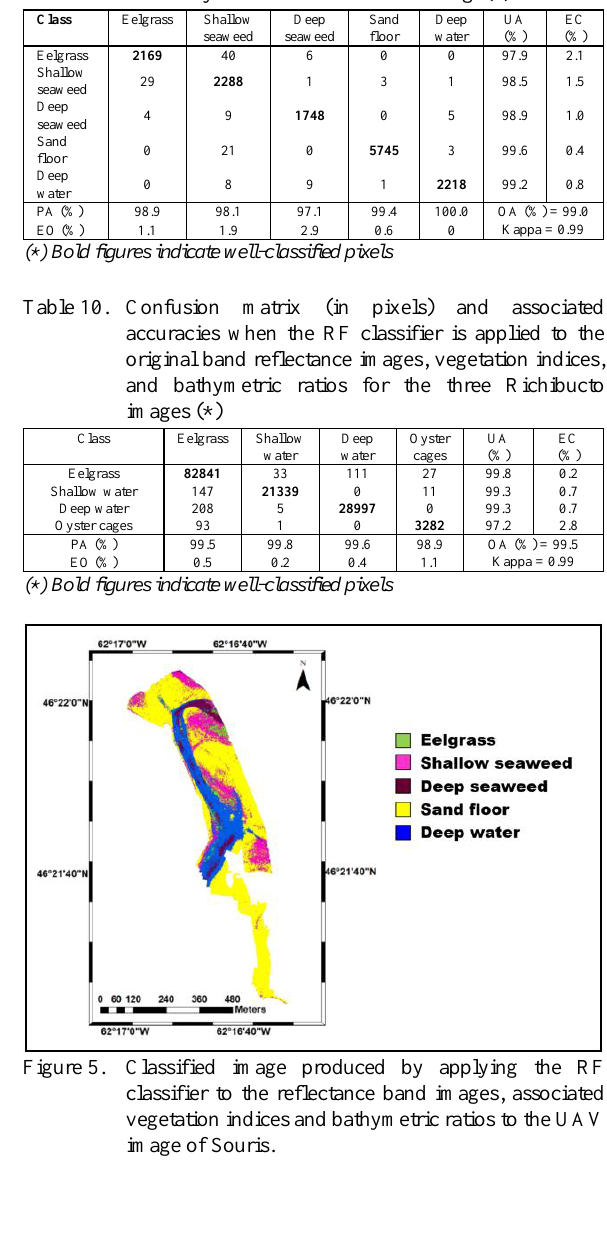
Confusion matrix (in pixels) and associated accuracies when the RF classifier is applied to the original band reflectance images, vegetation indices, and bathymetric ratios the Souris image(*)